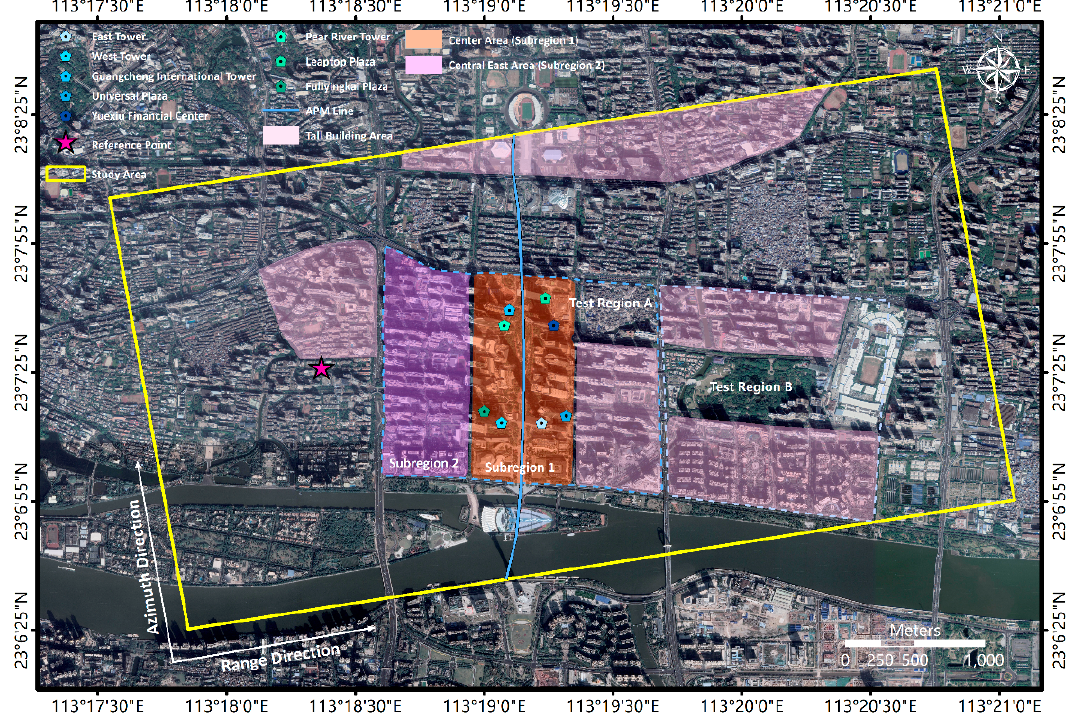
Figure 4. Study area of the staring spotlight monostatic pursuit stack over Guangzhou.